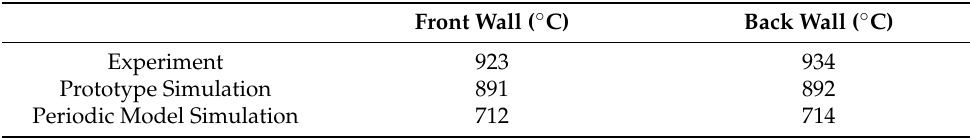
Table 1. Average temperatures at the front wall and back wall of the